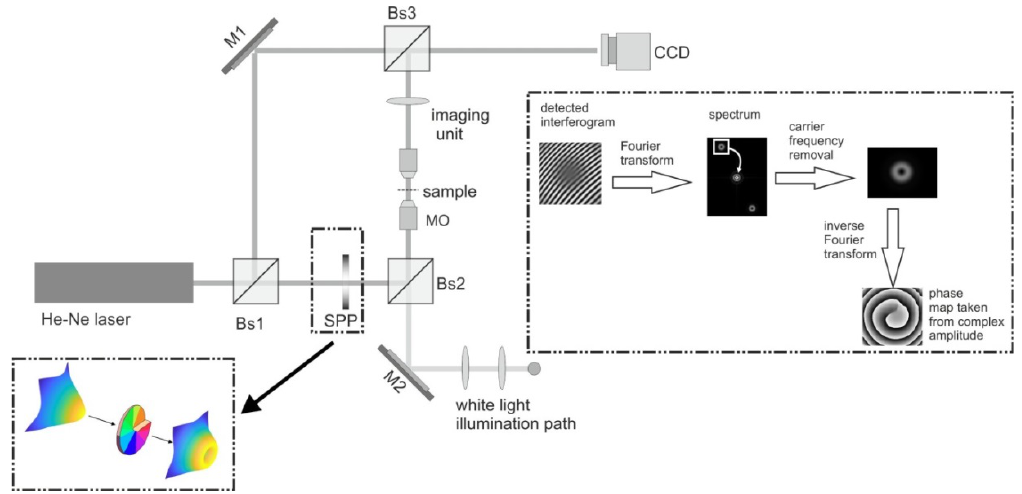
Figure 9. Scheme of the experimental setup. Bs1, Bs2, and Bs3, beam splitters; SPP, spiral phase plate; MO, microscope objective. Interferogram and scheme of phase extraction are shown in the inset.